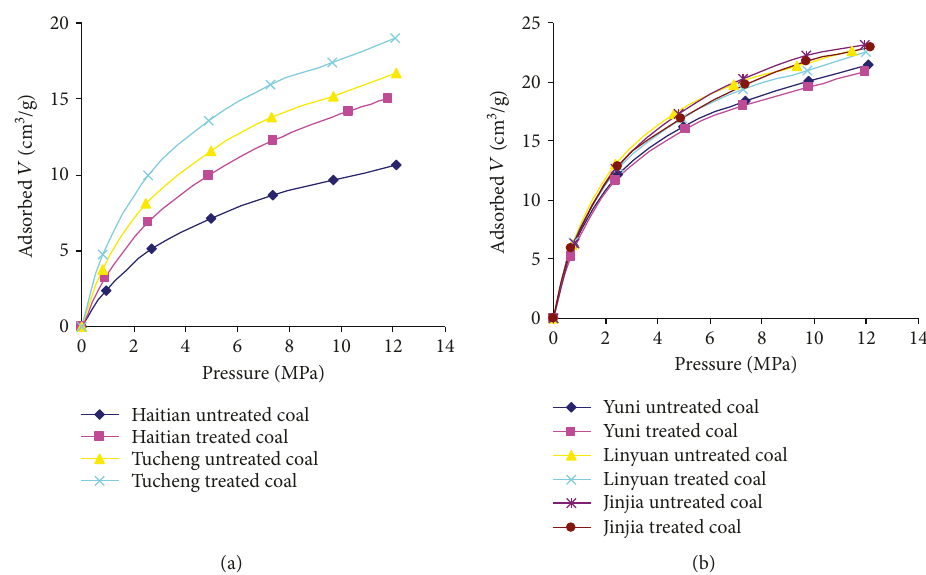
Figure 6: Curves of methane isothermal adsorption on samples: (a) samples of Haitian and Tucheng coals and (b) samples of Yuni, Linyuan, and Jinjia coals.